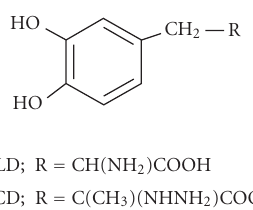
Figure 1. Structural formulae of the investigated